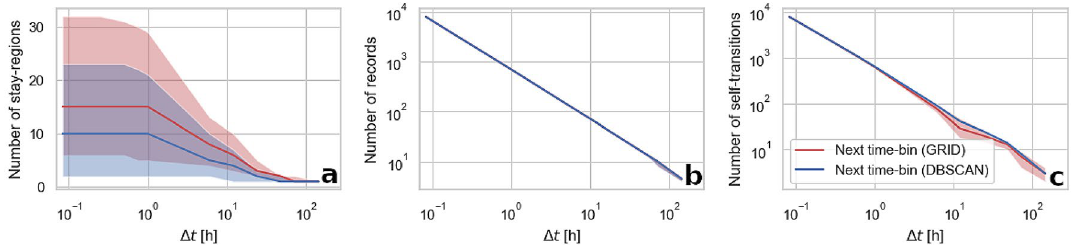
Figure 5. An impact of temporal resolution of data on three types of quantitative properties of the next time- bin sequences (number of stay-regions ( a ), number of records ( b ), and number of self-transitions ( c )). The lines represent the median value and the shaded area indicate the interquartile range of the measure calculated for all the users in the